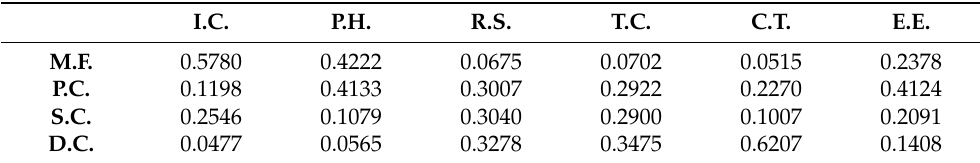
Table 11. Decision matrix for the application of VIKOR and TOPSIS.